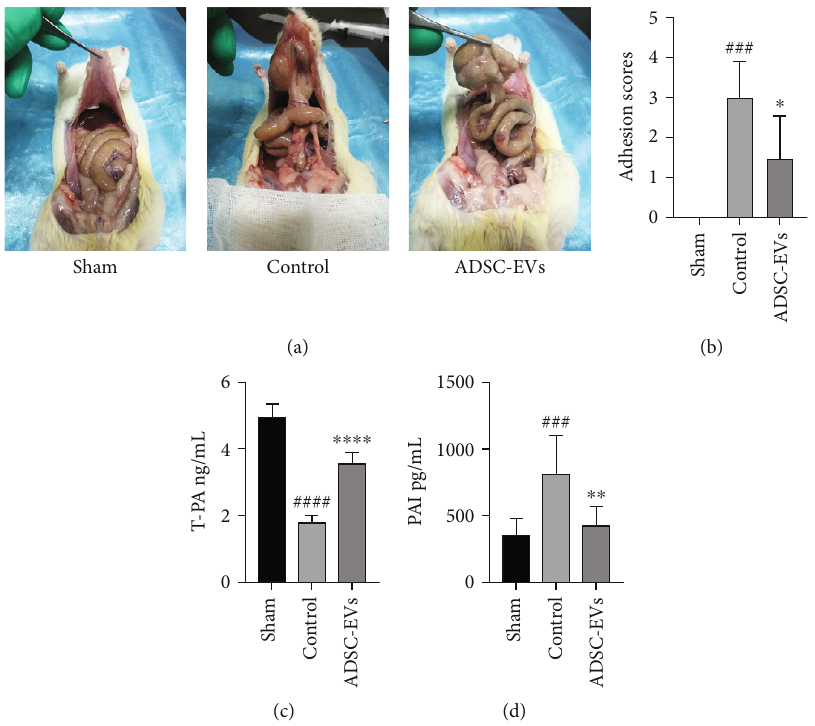
Figure 3: The Nair scores and fi brinolytic system for each group. (a) The severity of adhesions in each group. (b) The Nair score for each group (vs. control group, ∗ P < 0 : 05 ; vs. sham group, ### P < 0 : 001 ). (c, d) t-PA and PAI-1 protein levels in peritoneal fl uid. Data are expressed as the mean standard error of the mean (vs. ∗∗ P < 0 : 01 and ∗∗∗∗ P < 0 : 0001 ; vs. sham group ### P < 0 : 001and #### P < 0 : 0001